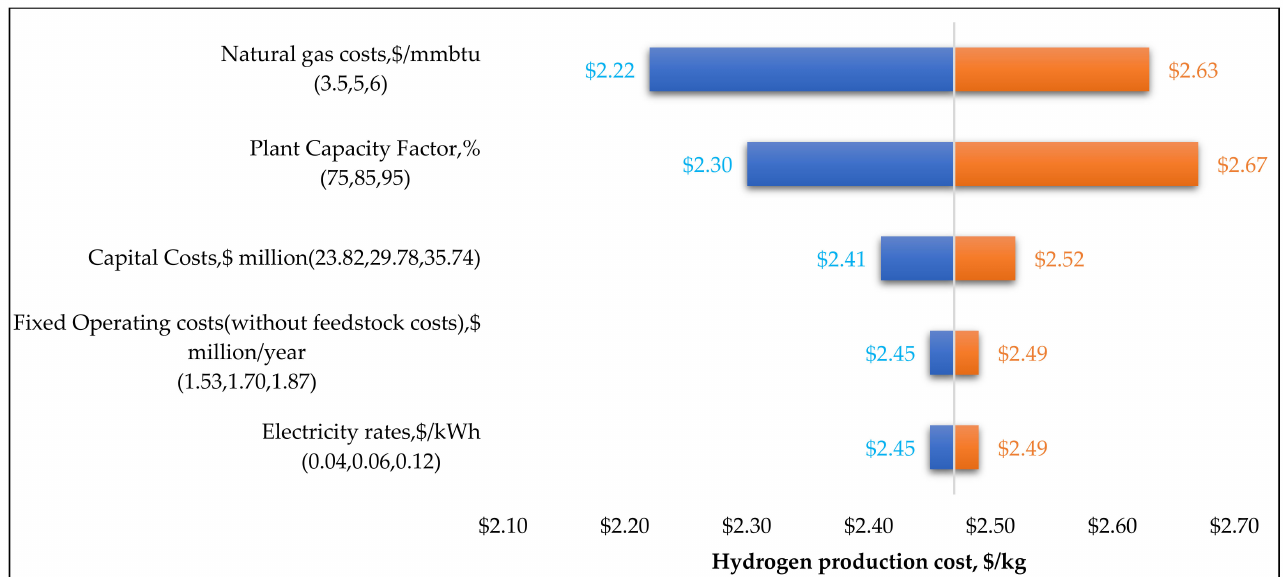
Figure 8. Range of hydrogen production costs for a 30 tpd central SMR